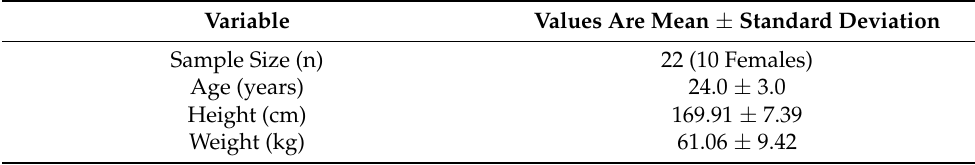
Table 1. Demographic information of study